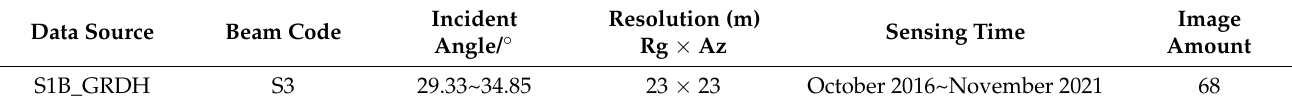
Table 1. Sentinel-1 dataset parameters.